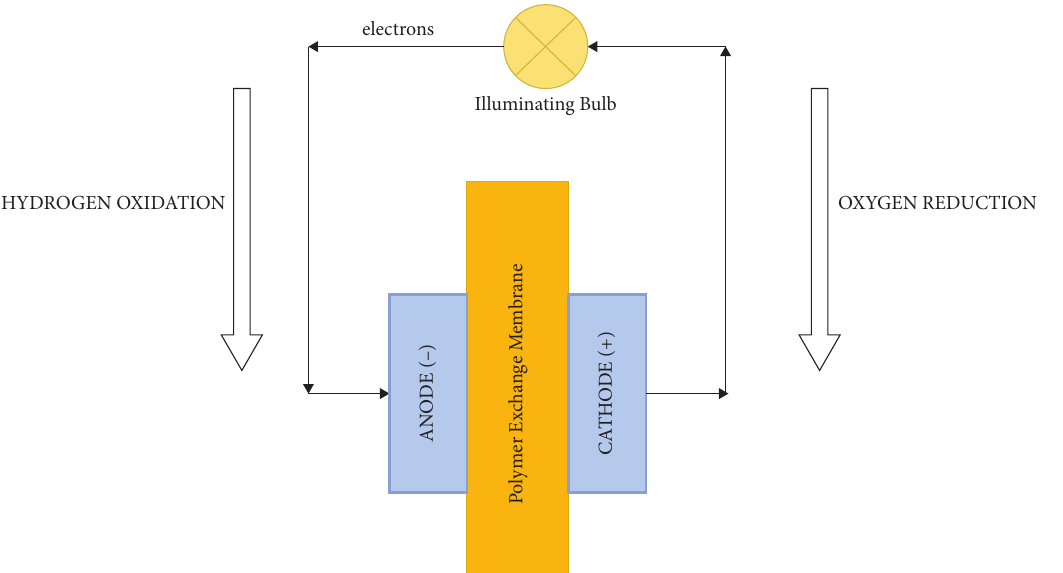
Figure 22: Reactions (oxidation and reduction) taking place in the PEMFC (polymer exchange membrane fuel cell). Illuminating bulb shows that the current is flowing through the